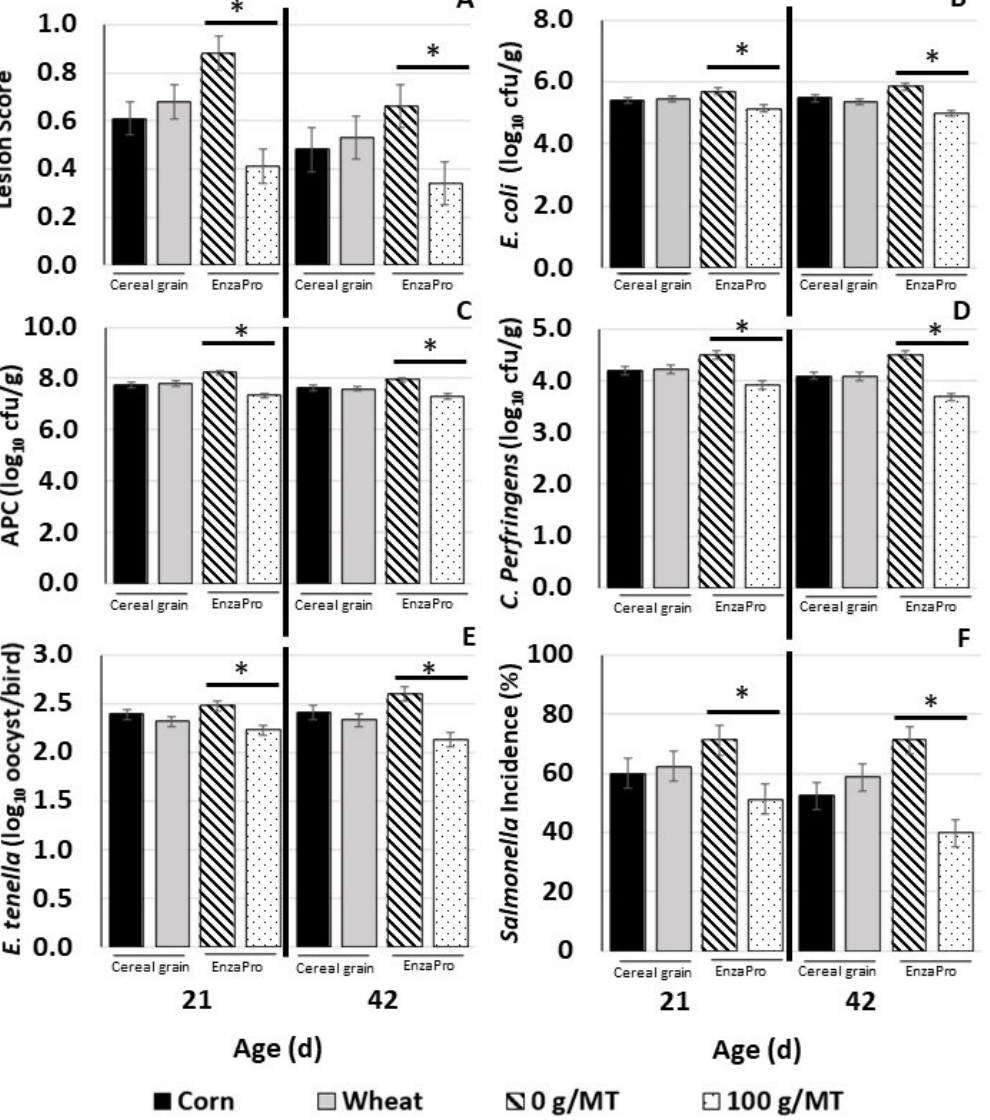
Figure 1. Least-square means for intestinal coccidia lesion scores and pathogen load measured at 21 and 42 d of age for the main effects of cereal grain (corn and wheat) and EnzaPro (0 and 100 g/MT). ( A ) Lesion scores in broiler intestines at 21 and 42 d; ( B ) E. coli log 10 cfu/g counts in digesta;